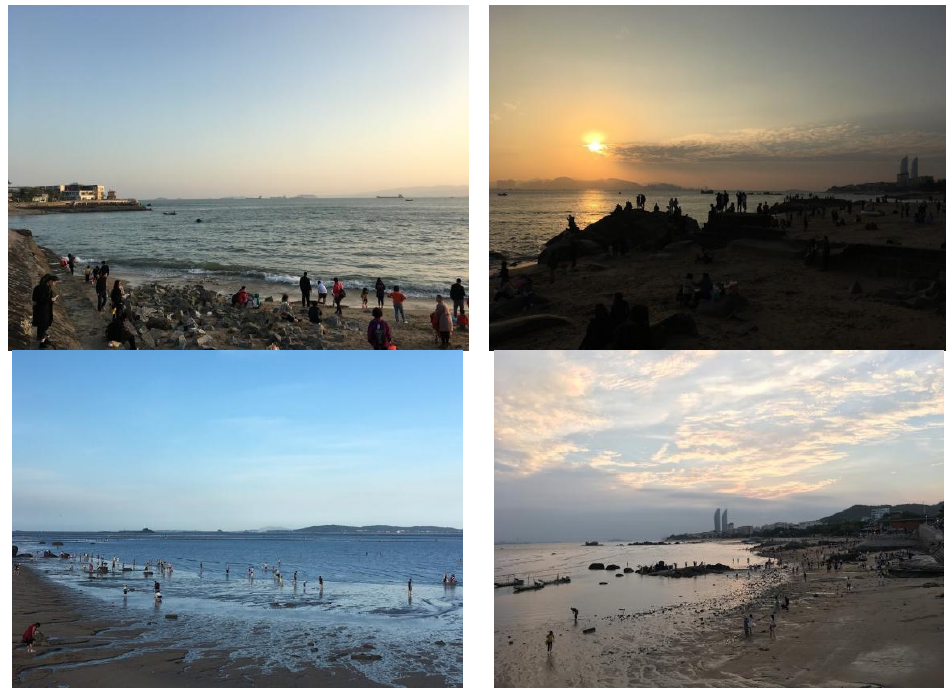
Figure 4. Seaside scenery in the vicinity of Xiamen Island Ring Road. Source: Photo by the authors.